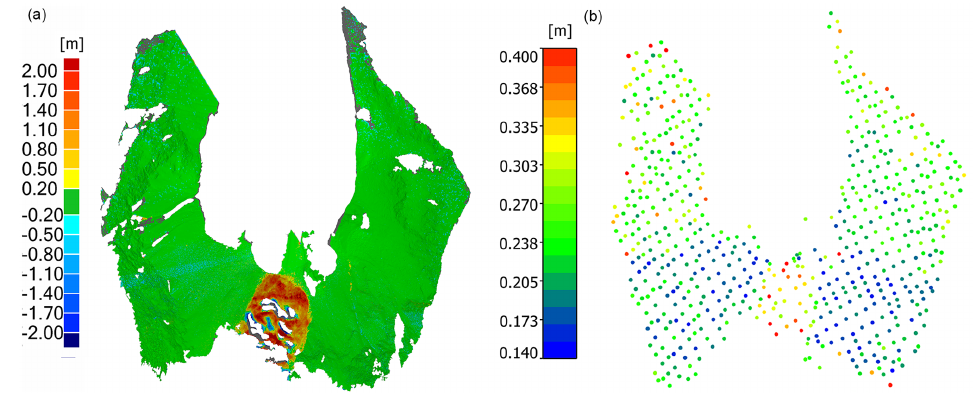
Figure 8. Change map of the Hinterer Langtalkar (a) and spatial uncertainties (m) for individual octree cells (b) .